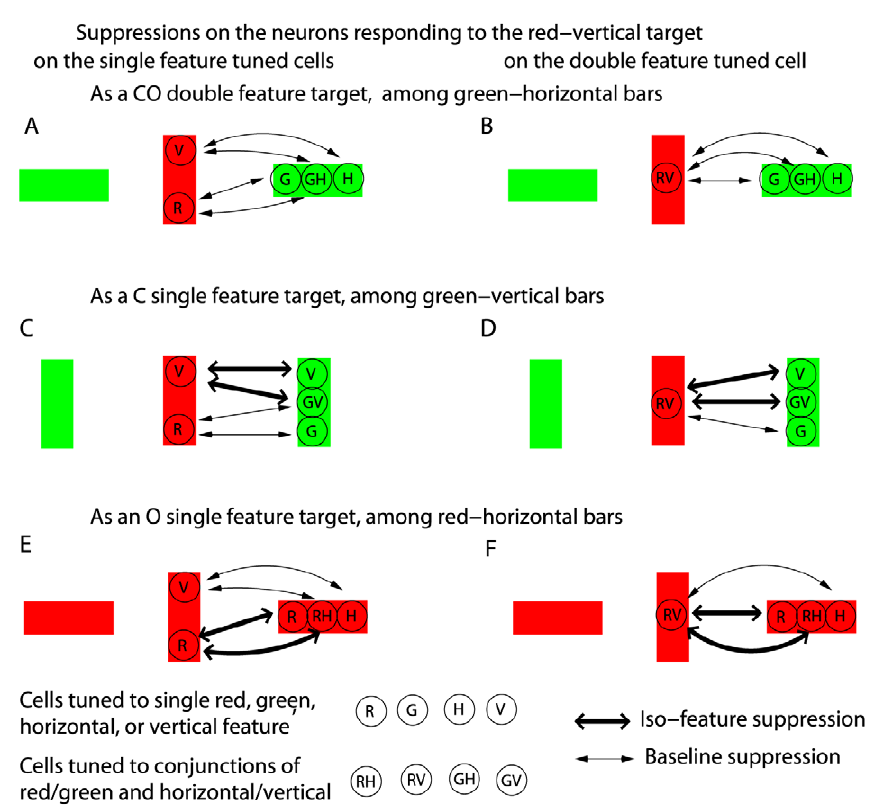
Figure 8. A schematic for suppression on neurons responding to the target in feature singleton search. Cases for a CO target (A and B), a C target (C and D), and a O target (E and F) are shown separately. Red and green bars are visual inputs. Circles on a bar mark neurons activated by the bar. Each neuron is marked by its preferred feature as red (R), green (G), horizontal (H), vertical (V), or a conjunction of them. Lines and curves with arrows mark (effective) suppression between two neurons, thicker for stronger suppression when the two neurons prefer the same feature. For clarity, suppression on the single feature tuned cells are shown separately (in A, C, and E) from that (in B, D, and F) on the double feature tuned cells, and interactions between the neurons responding to non-targets are not shown. Among single feature tuned neurons activated by the target, the C neuron (‘R’) is more suppressed when the target is an O target, whereas the O neuron (‘V’) is more suppressed when the target is a C target. Without the conjunctive neurons, the strongest response evoked by the CO target will be the same as the larger one of the strongest responses evoked by the C and the O targets. The CO neuron (‘RV’) responding to the target is least suppressed for the CO target (to have the redundancy gain), if suppression between conjunctive neurons is weaker when their preferred features are different in both rather than one feature dimensions (i.e., W 11 v W 10 and W 11 v W 01 , see equation (19)), or if the suppression from a single feature tuned neuron (C or O neuron) on a conjunctive neuron is weaker when they prefer different features in their shared feature